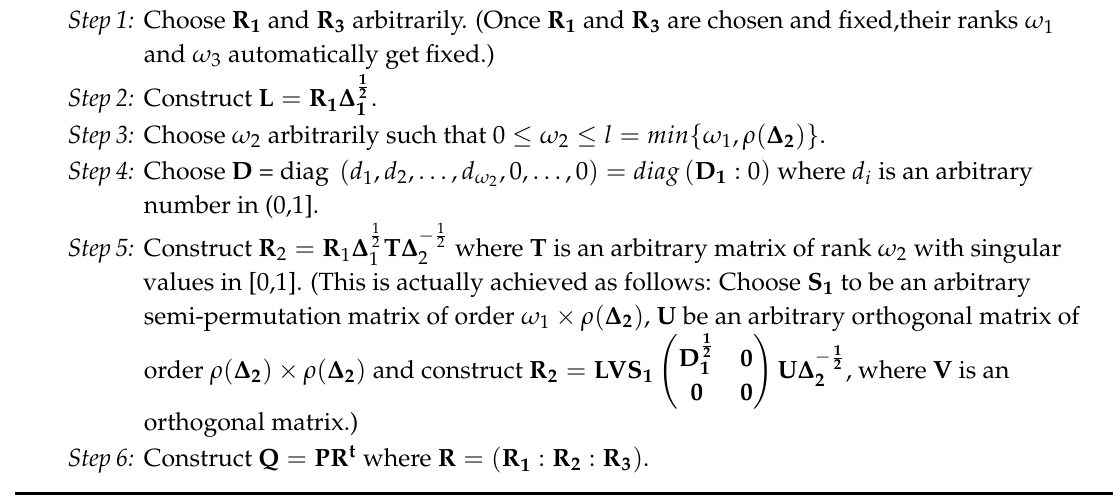
Algorithm 1: The Pochiraju